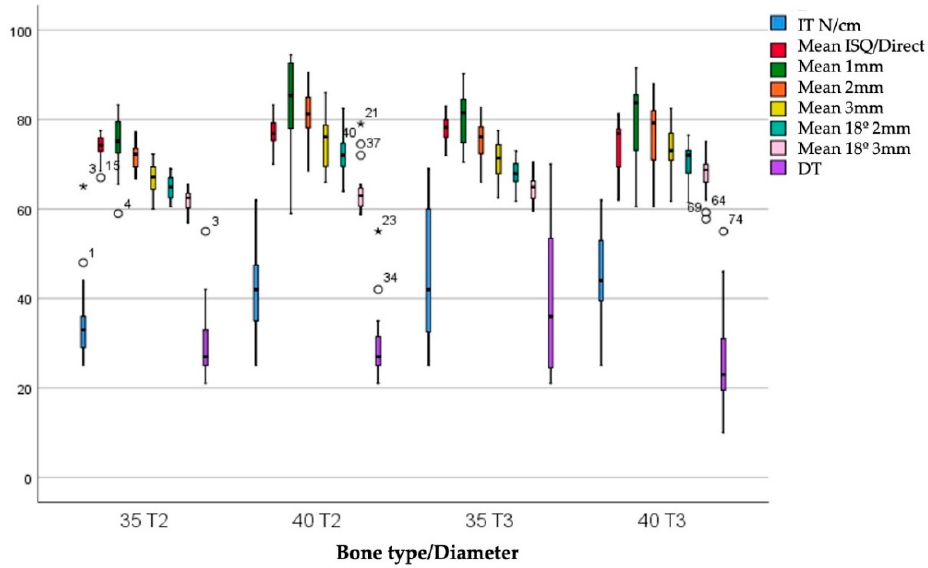
Figure 5. IT and DT. ISQ values according to bone type.